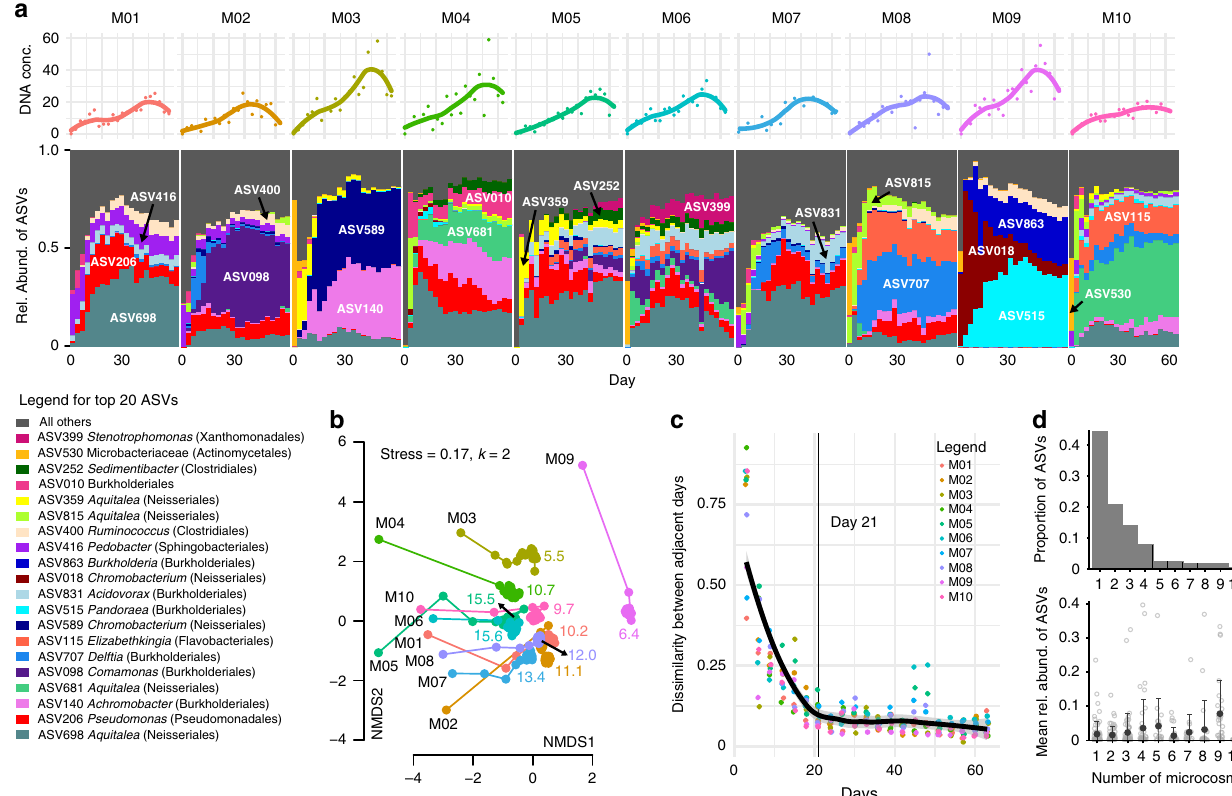
Fig. 1 Microcosm communities approach distinct equilibria. a Relative abundances of the top 20 Amplicon Sequence Variants (ASVs) across the ten microcosms during the course of the serial transfer experiment. ASVs are listed one time each on the bar plot, with taxonomic classi fi cation in the legend. The DNA concentrations for each timepoint are graphed above as points, with a Loess fi t as a solid line. b Communities change quickly and then stabilize in the two-dimensional Non-metric Multidimensional Scaling (NMDS) plot of Bray – Curtis dissimilarities of the microcosm community compositions. The microcosm name is listed in black next to the Day 0 point for each microcosm, and the lines connect the timepoints. Colored numbers indicate the mean effective number of species for each community post Day 21. c The Bray – Curtis dissimilarity of ASV relative abundances between adjacent days decreases over the course of the experiment. The thick black line shows a Loess fi t to all data points, and the thin line marks Day 21. d At the end of the experiment, most ASVs were present in only one microcosm (top), but ASVs present in more microcosms tended to have higher mean relative abundances (bottom), shown as black circles with ±1 standard deviation error